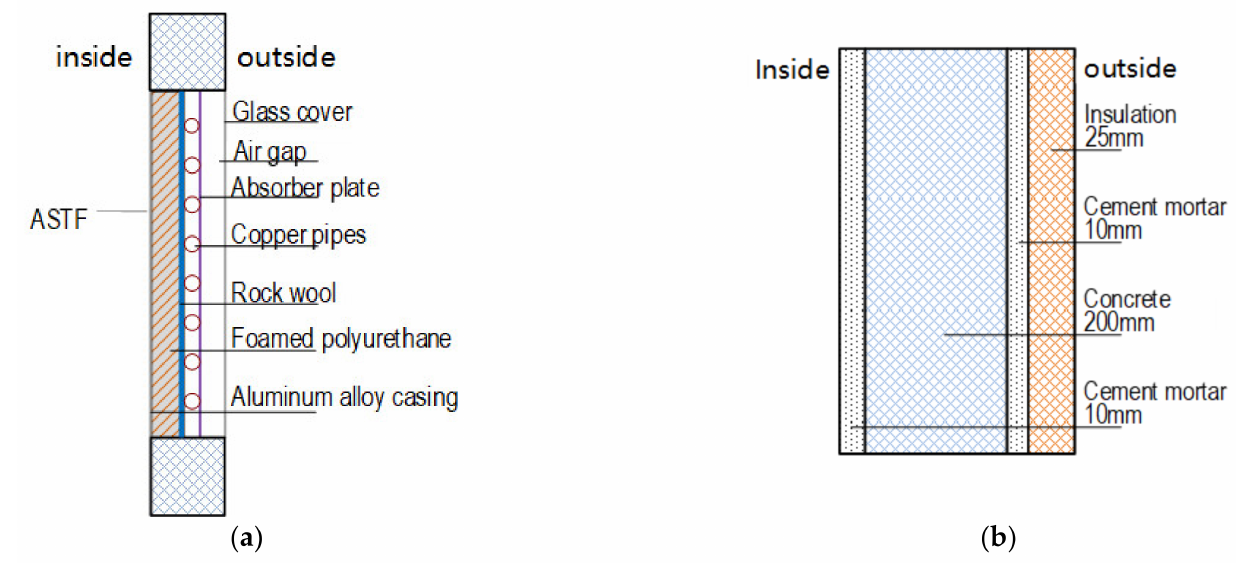
Figure 7. Structure comparison of ASTF and traditional wall ( a ) ASTF ( b ) traditional wall. Table 6. Physical properties of traditional wall layers. Material Concrete Cement Mortar